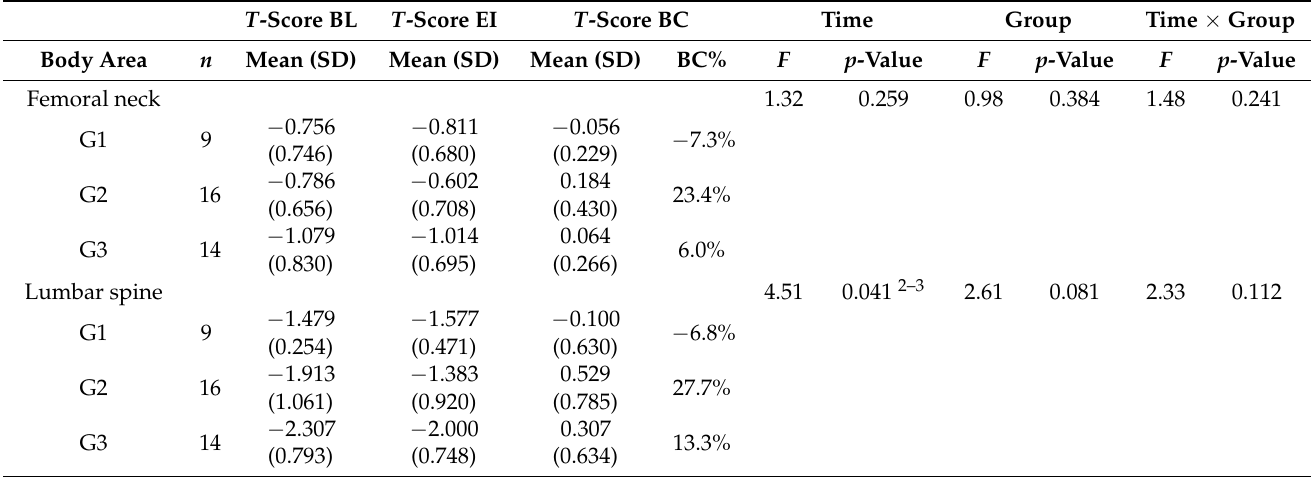
Table 2. T-score results before and after 2-years of